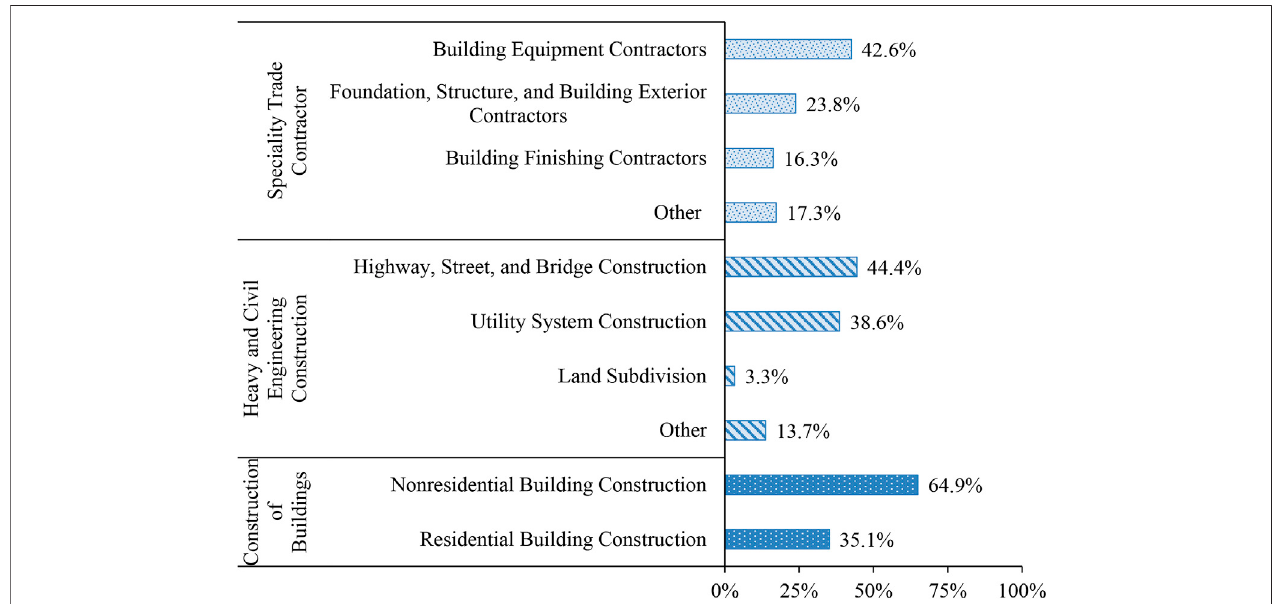
FIGURE 5 | Distribution of the construction-related complaints across the NAICS subcategories.